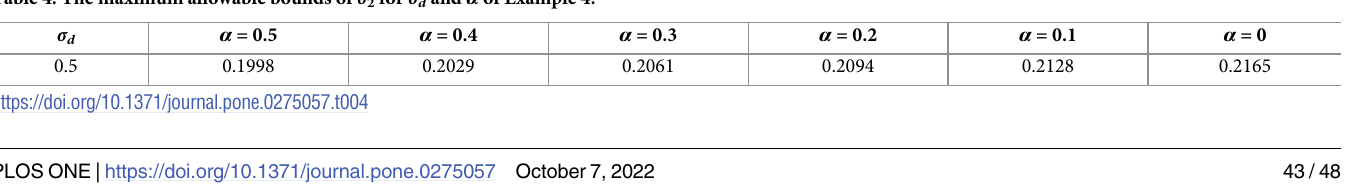
Table 4. The maximum allowable bounds of σ 2 for σ